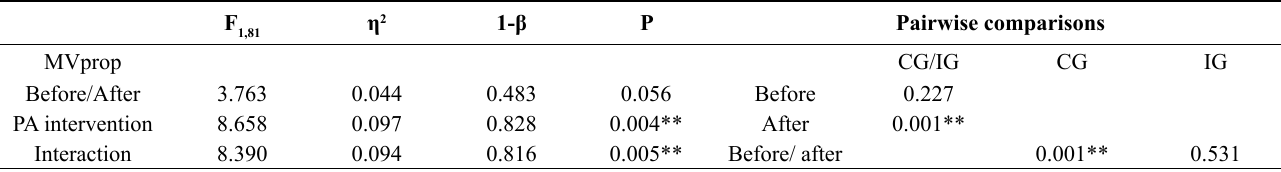
Table 5. Statistics obtained for lower trunk musculoskeletal capacity F η 2 1-β 1,81